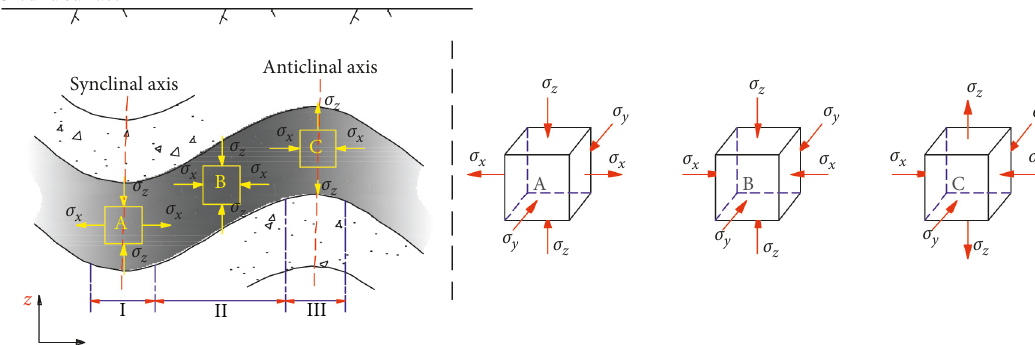
Figure 6: The influence of horizontal tectonic stress caused by folded structure on coal seam. Note: I, syncline structure influence zone; II, wing structure influence zone; III, anticline structure influence zone.